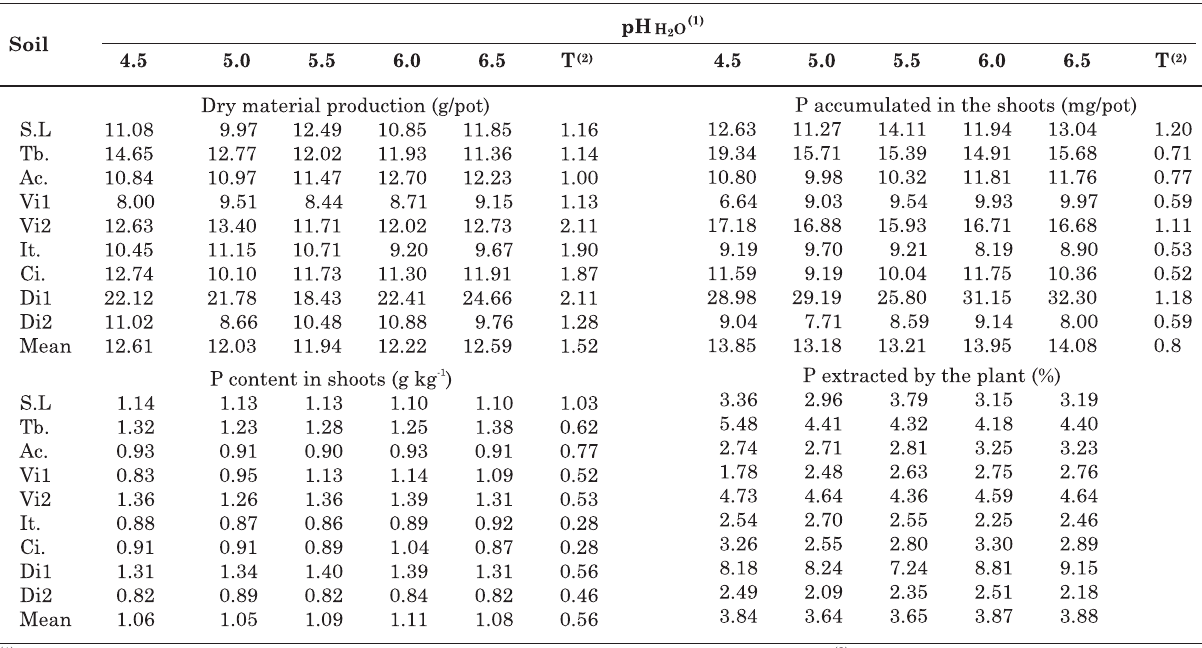
Table 2. Effect of incubation of soil samples fertilized with triple superphosphate, at varying acidity levels, on sorghum growth and phosphorus